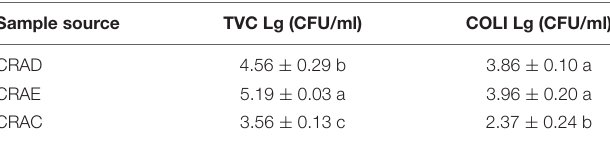
TABLE 2 | The bacterial culture count of the chicken carcass rinse at three key processing points. Sample source